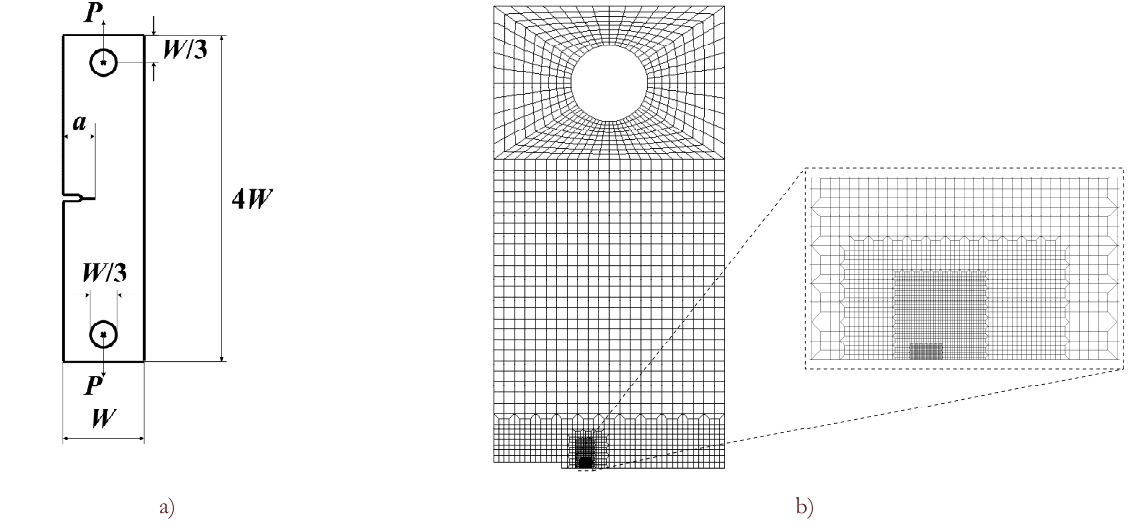
Figure 2: SEC specimen: a) geometry and b) FE model with an highlight of the crack tip